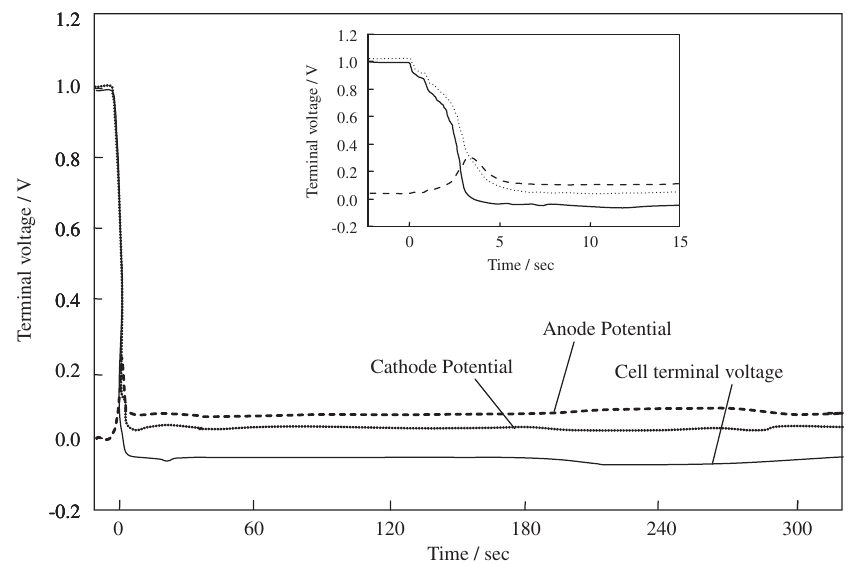
Fig. 2 – Time-dependent changes in the anode and cathode potential during the cell-reversal experiment. Figure 2. Anode and cathode potential change in cell reversal caused by oxygen starvation. Reproduced with permission from [5]. Copyright Elsevier,